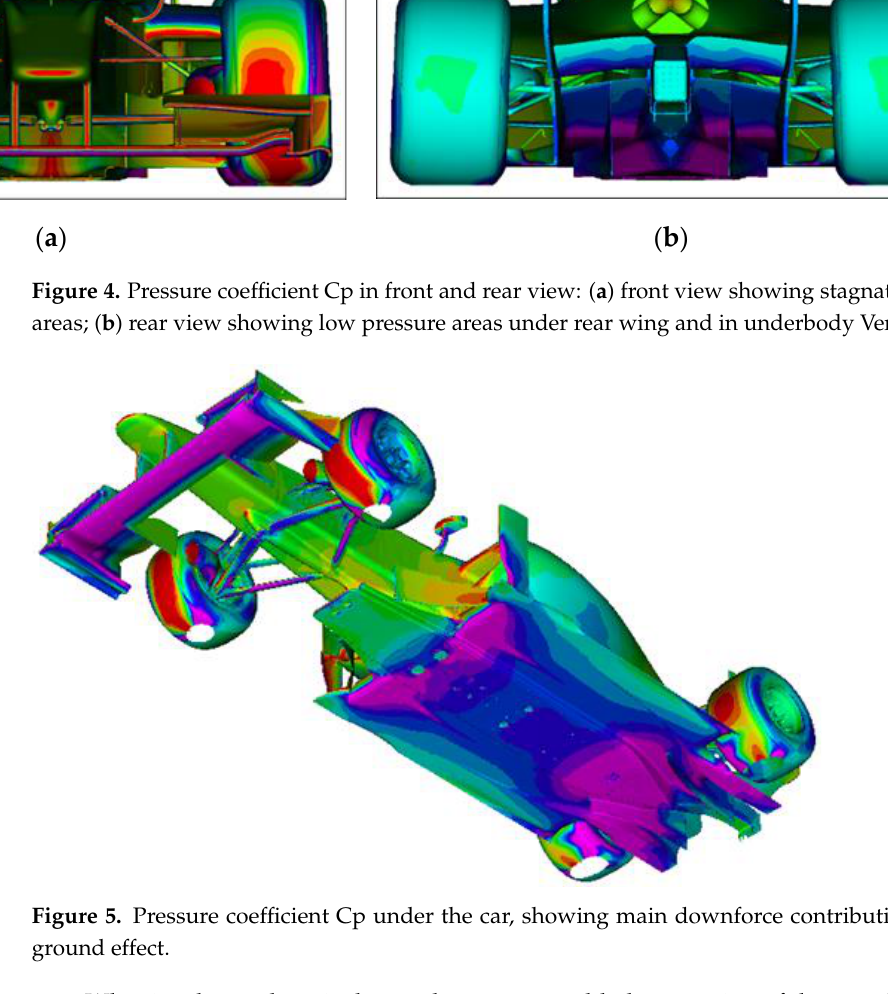
Figure 6. Drag coefficient C D S vs. Front Ride Height FRH and Rear Ride Height RRH. Actual figures are not shown for confidentiality reasons. The percentage variation is computed with reference to